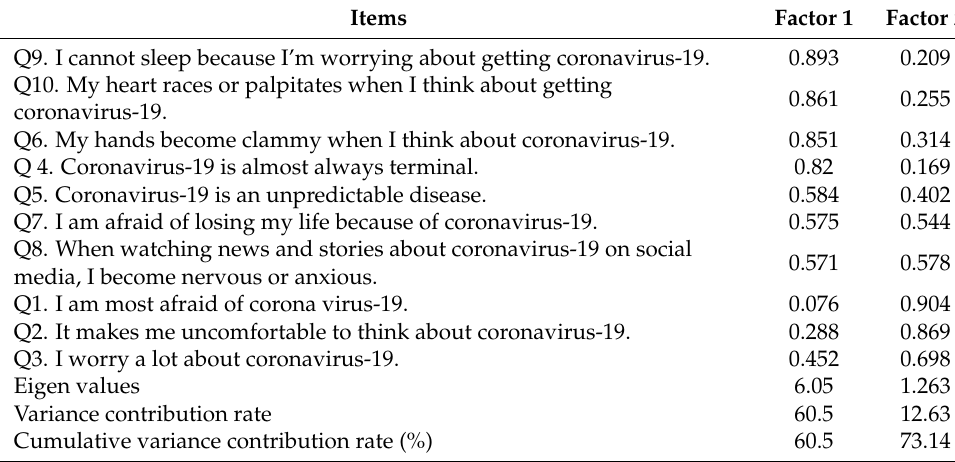
Table 4. Fit indices of models in the CFA of the Fear of COVID-19 Scale in test sample 2. χ 2 (df.)